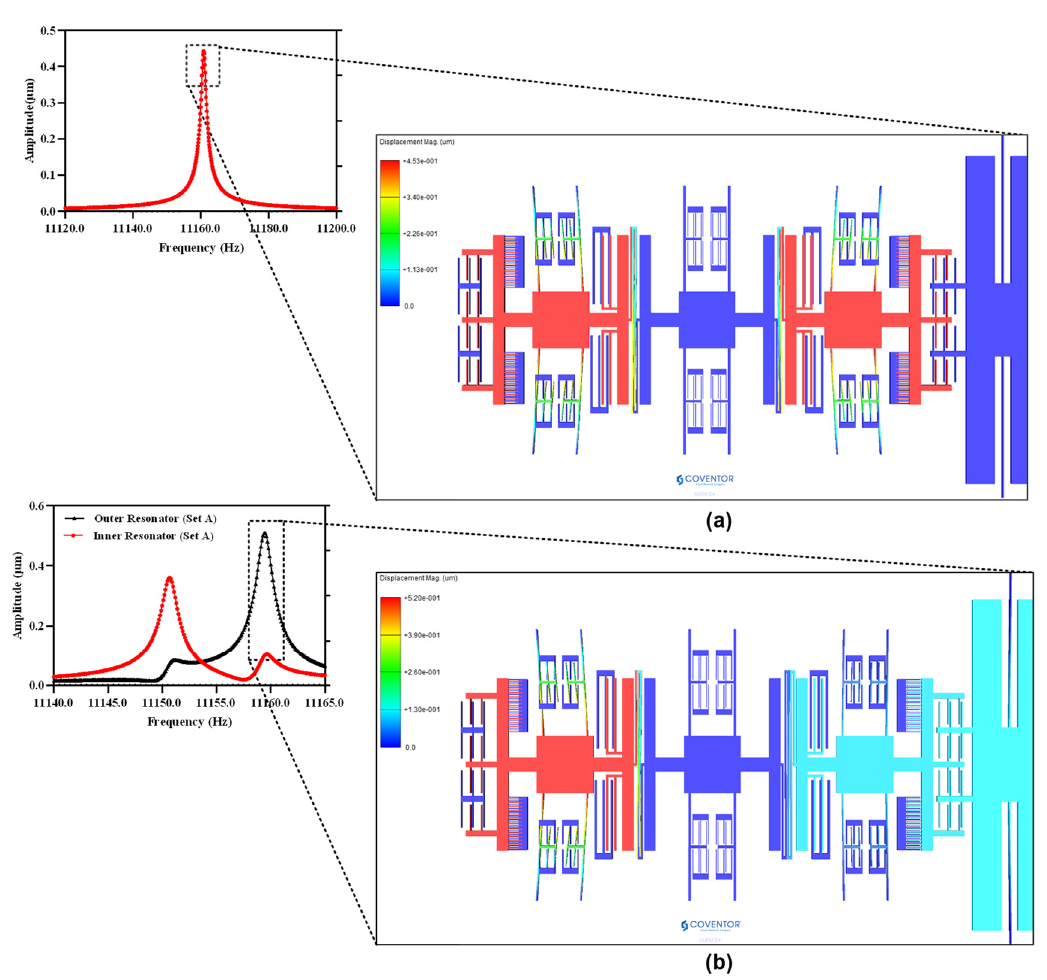
Figure 5. Frequency response of the 3-DoF weakly coupled resonators in Set A ( a ) at 0 g with AR = 1 ( b ) at 0.5 g with AR = 6.2.